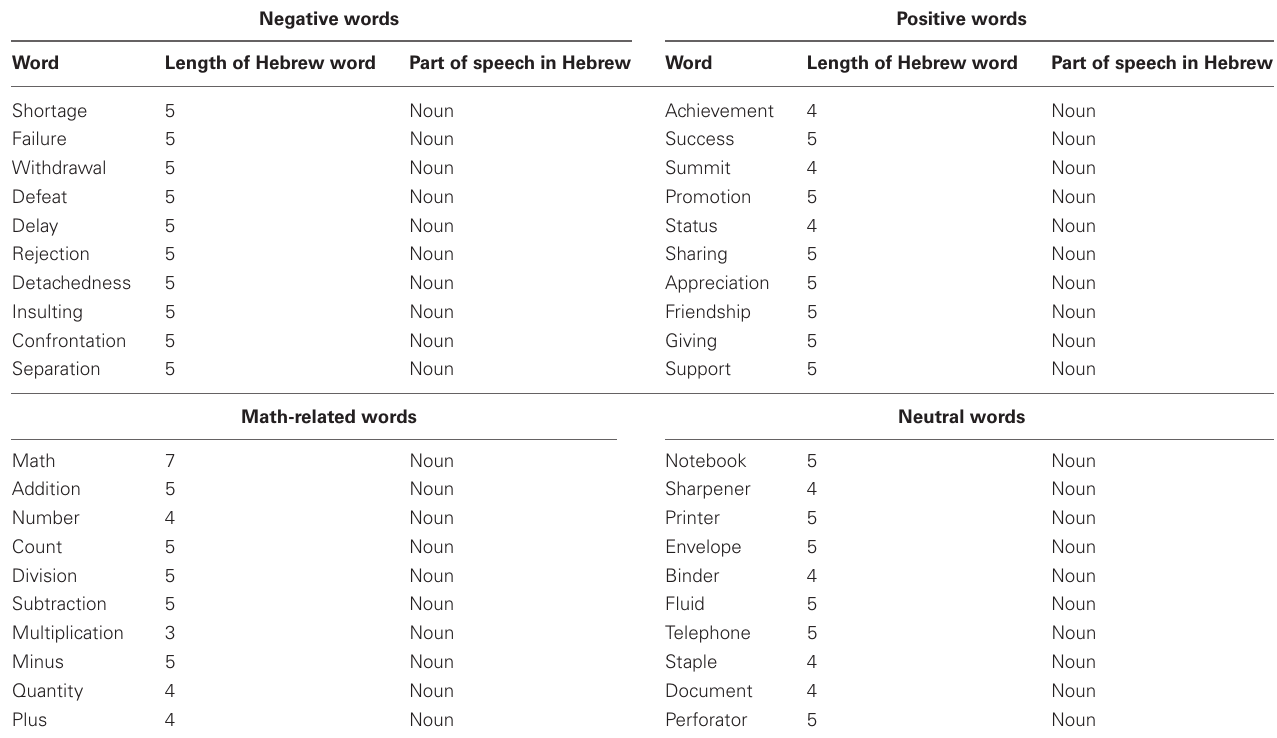
Table A2 | Primes used in the experiment—list and description.